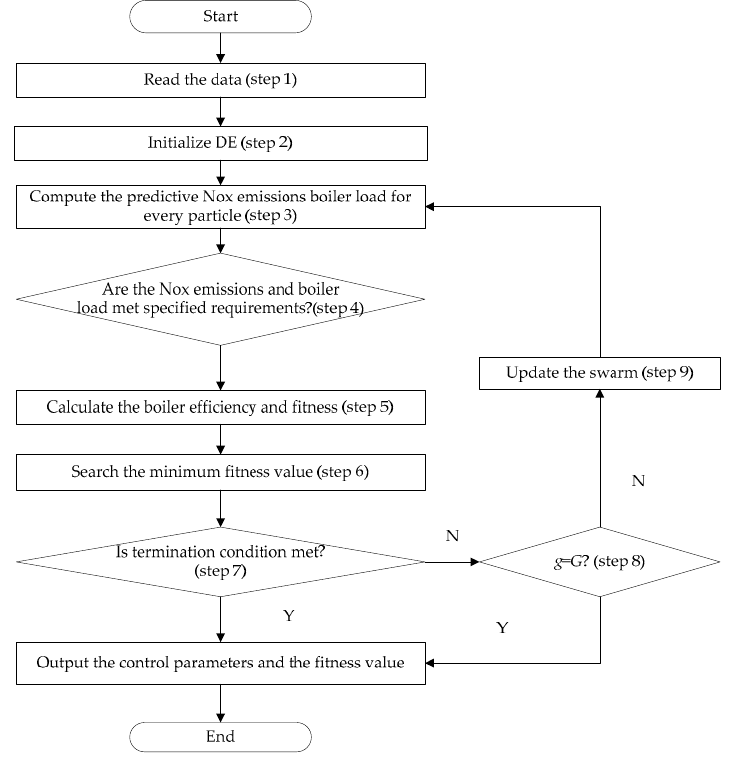
Figure 8. The rolling optimization flowchart.